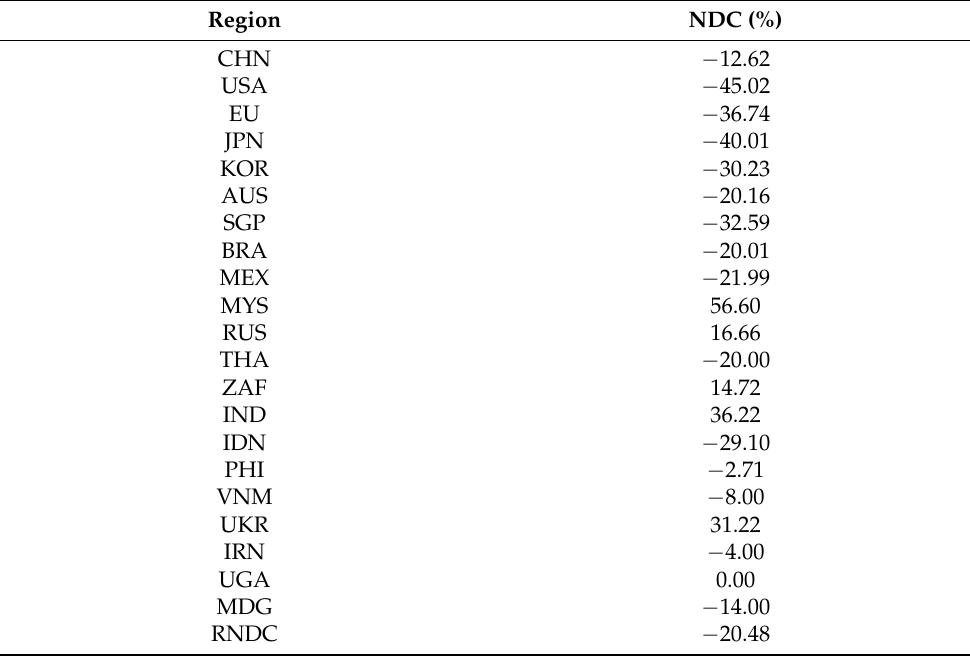
Table 4. 2030 NDC greenhouse gas emissions reduction targets by region. Region NDC (%) CHN − 12.62 USA −